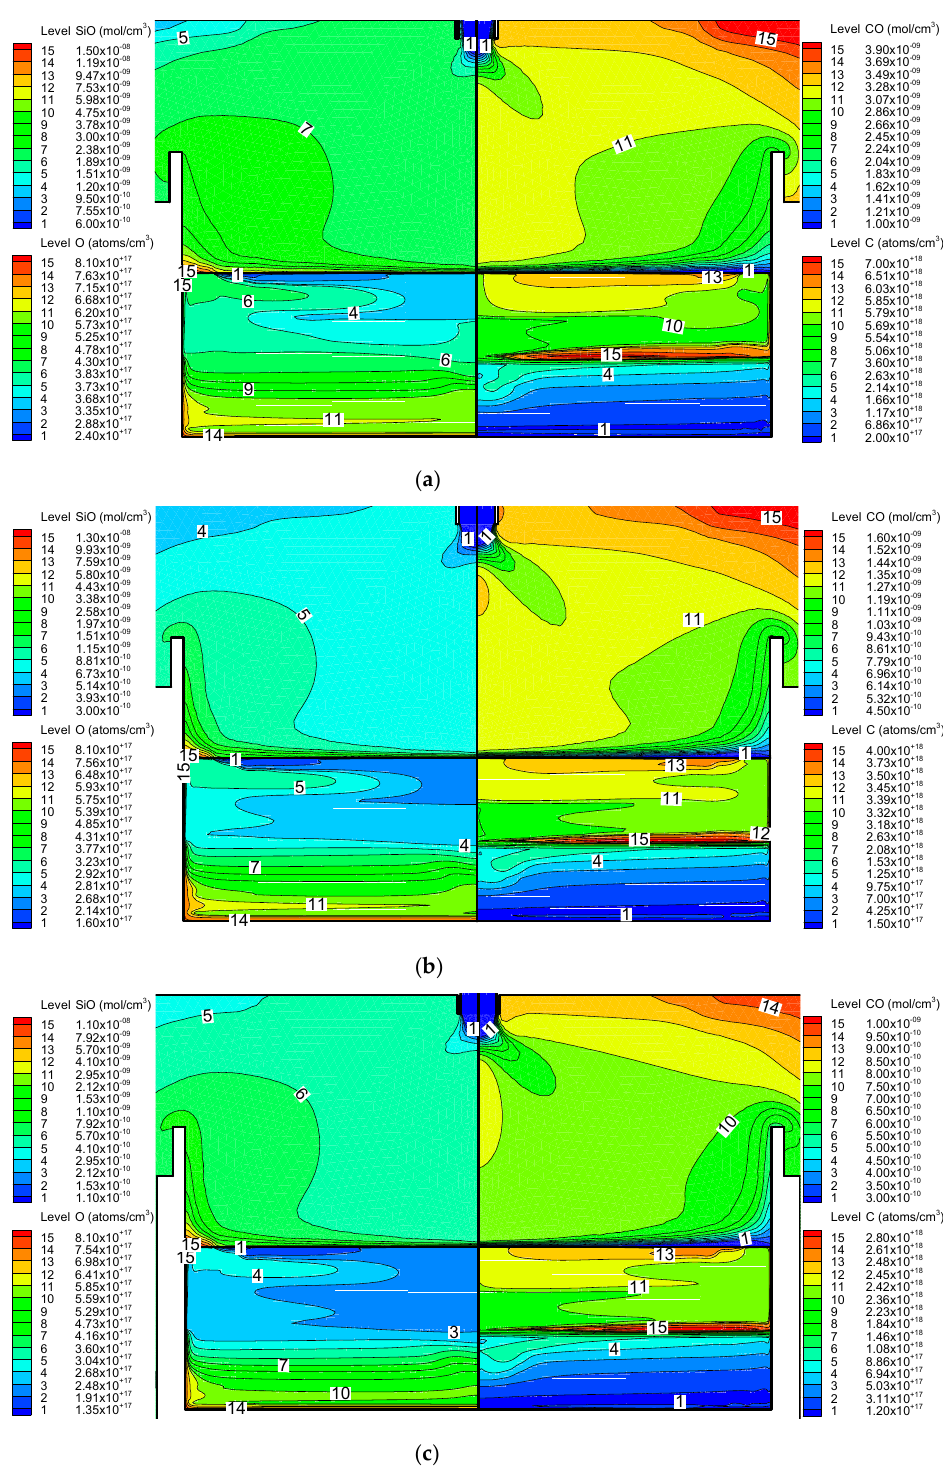
Figure 5. Local impurity distribution for different argon flow rates at S.F. = 50%: ( a ) 10 L/min, ( b ) 30 L/min, ( c ) 50 L/min. Contour numbers in the silicon and argon region represent the contour value.